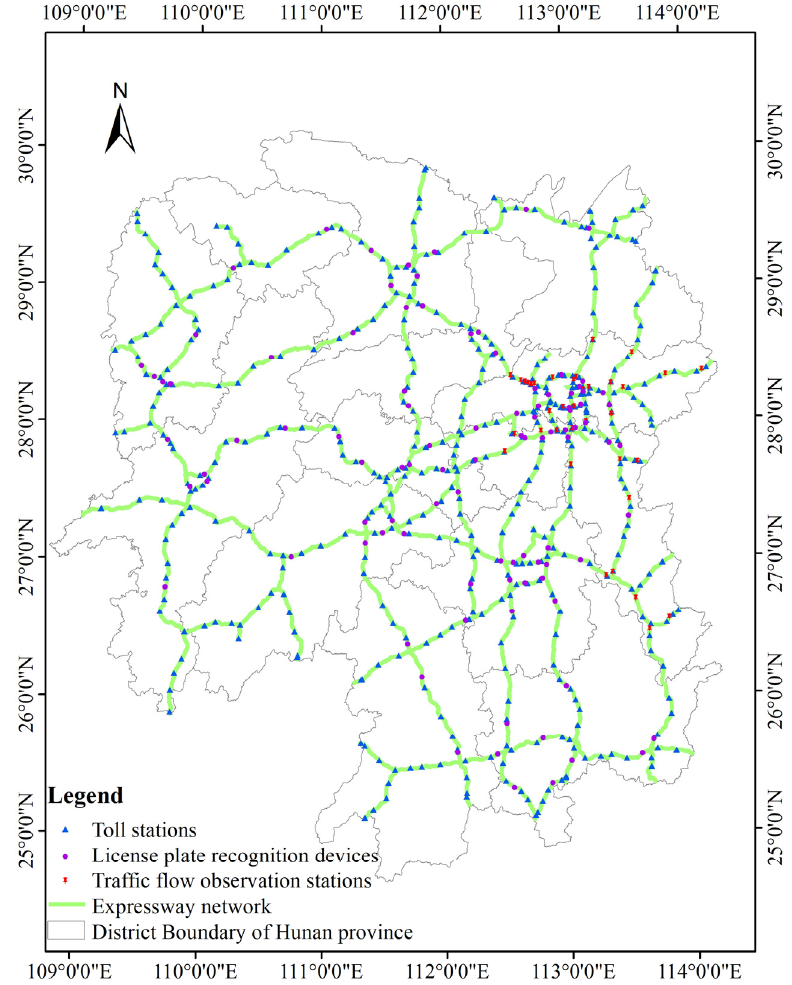
Figure 2. The express highway network and different observation stations.